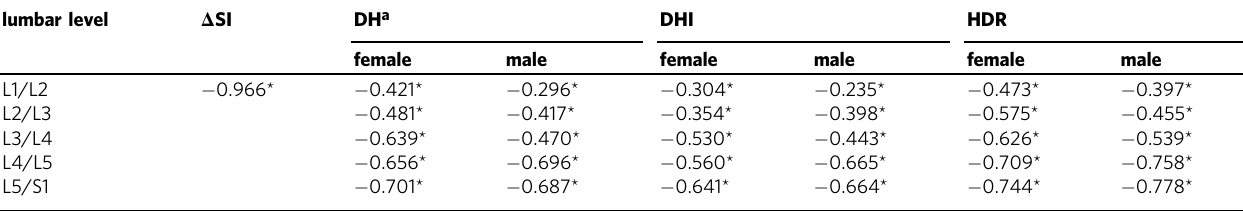
Table 4 Correlations between IVD parameters and modi fi ed P fi rrmann grading. lumbar level